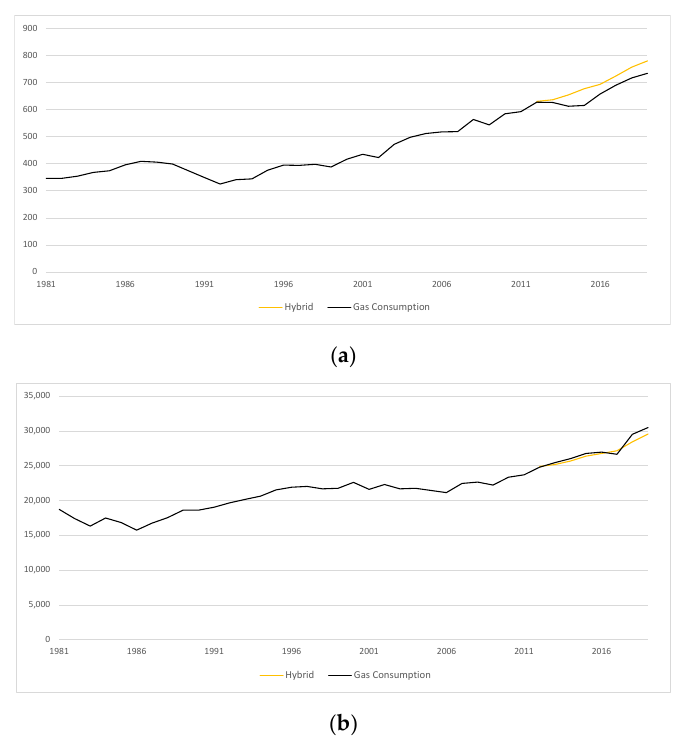
Figure 5. Natural gas consumption [TJ]–actual values and forecasts: ( a ) Poland; ( b ) US.